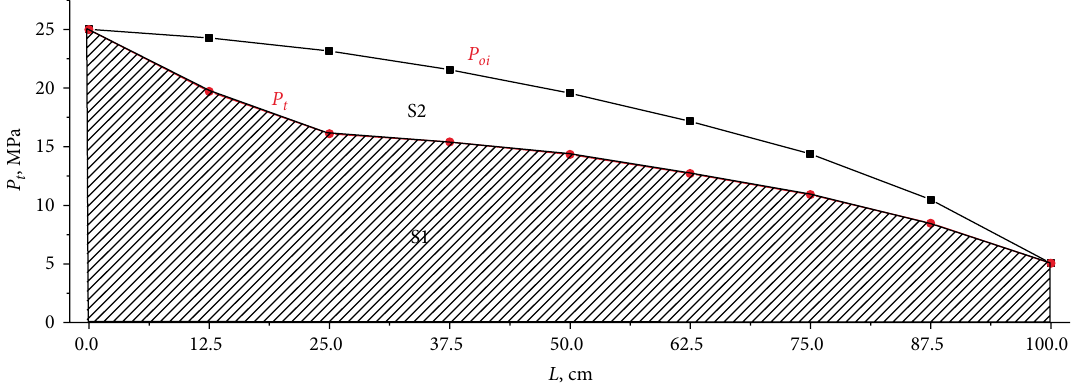
Figure 20: The energy supplement efficiency of water, CO